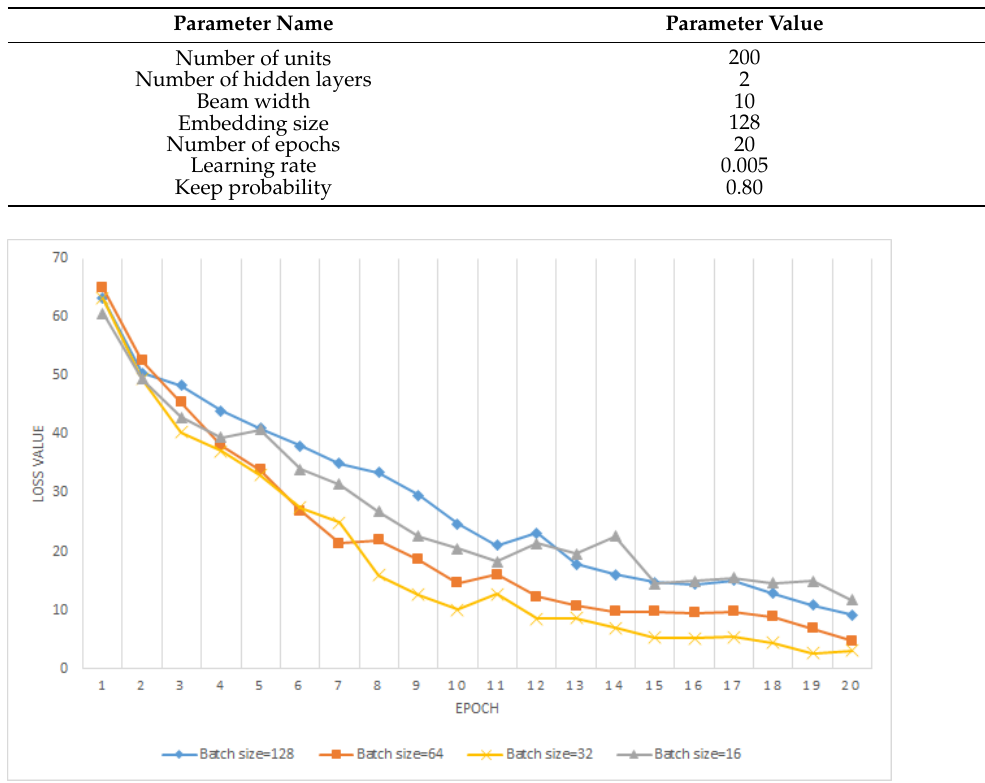
Table 7. Experiment parameters for batch size sensitivity analysis.